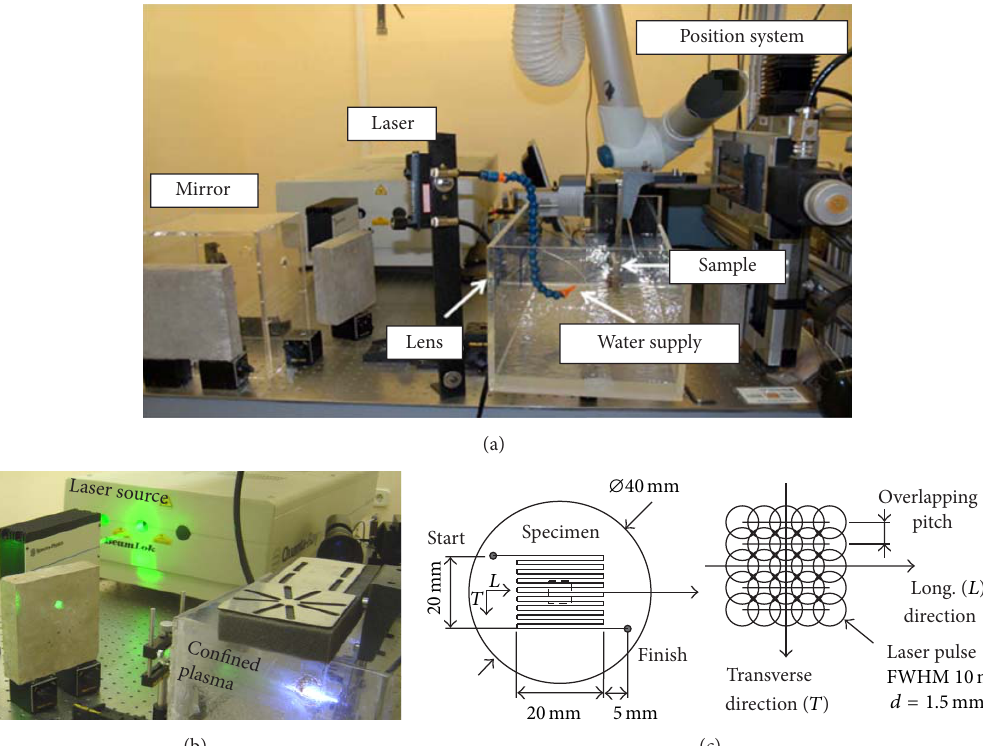
Figure 2: (a) Experimental LSPwC set-up; (b) generation of confined plasma during LSPwC and (c) schematic presentation of the LSPwC surface